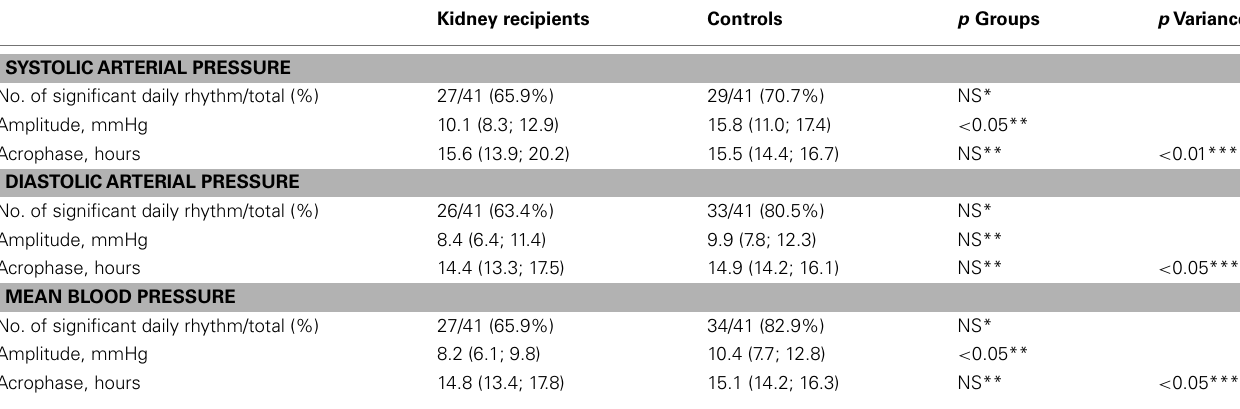
Table 3 | Comparison of parameters analyzed by Cosinor method between renal transplant recipients and controls.